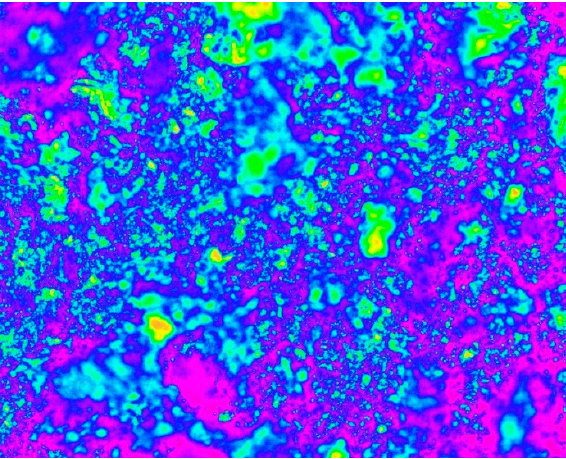
Figure A4. Activated carbon pellet (0.5 cm × 1 cm). Polished section, reflected light. Field of view = 1.3 mm, showing activated carbon (purple) separated by porosity (blue, yellow, green).